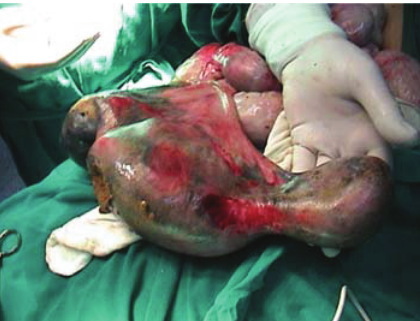
Figure 1: Intraoperative view showing the appendix that measured about 55 cm and was full of fecal materials.